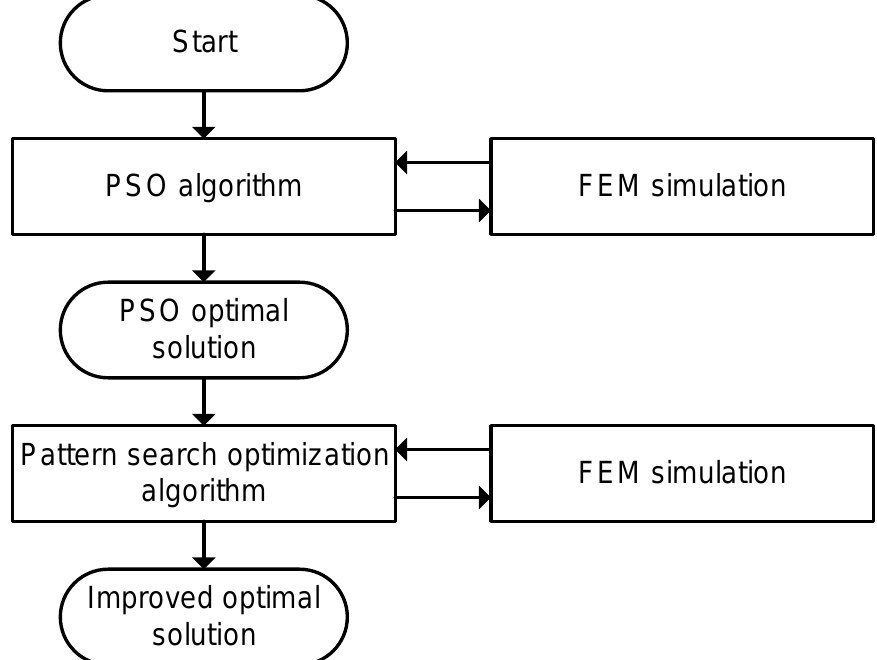
Figure 10. Flow chart: direct optimization routine with FEM as the cost